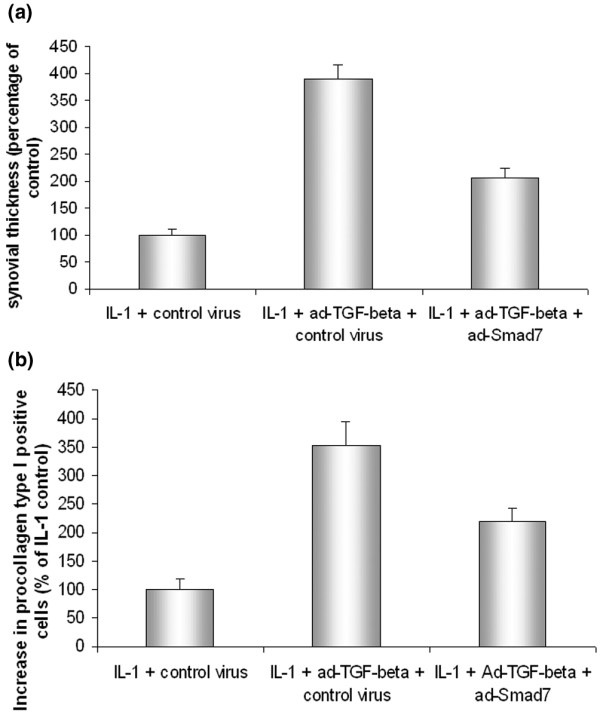
Cartilage damage was introduced by interleukin-1 (IL-1) injection, and 2 days later transforming growth factor-β (TGF-β) was injected intra-articularly combined with Ad-luciferase or Ad-Smad7. Two weeks after adenoviral transfection, knee joints were isolated for assessment of fibrosis. (a) Synovial thickness had increased significantly (p < 0.005) after exposure to TGF-β. The TGF-β-induced increase was reduced by simultaneous overexpression of Smad7 (p < 0.05). (b) The number of procollagen type I-expressing cells had increased after TGF-β exposures accordingly (p < 0.0005). This was also partially blocked by Smad7 (p < 0.005). Error bars display standard error.